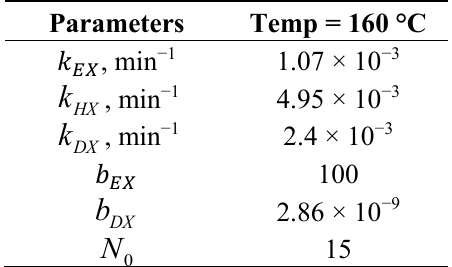
Table 2. Parameters in xylose, xylooligosaccharide and furfural kinetic models.